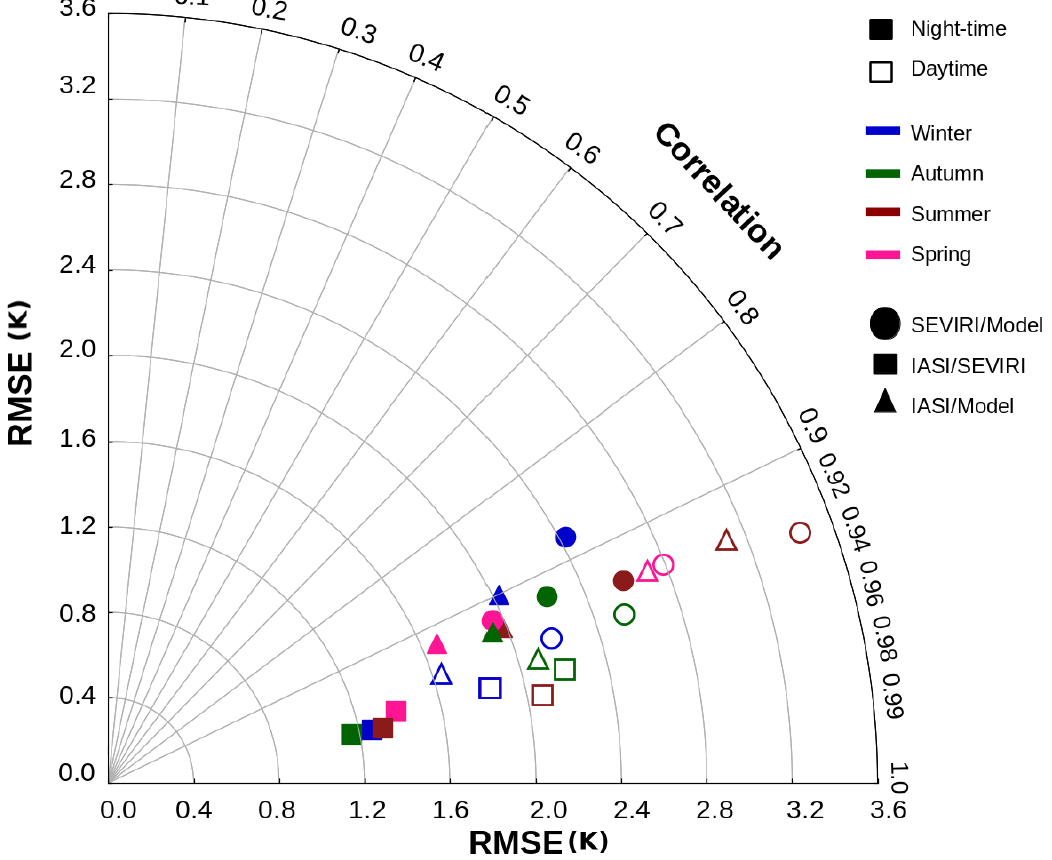
Figure 9. Statistics of differences between SEVIRI and IASI for both nighttime and daytime comparisons, during months in Winter (blue), Autumn (green), Summer (red) and Spring (pink). The squares represent the differences between IASI LSTs and SEVIRI LSTs, the circles represent the differences between SEVIRI LSTs and model LSTs while the triangles represent the differences between IASI LSTs and model